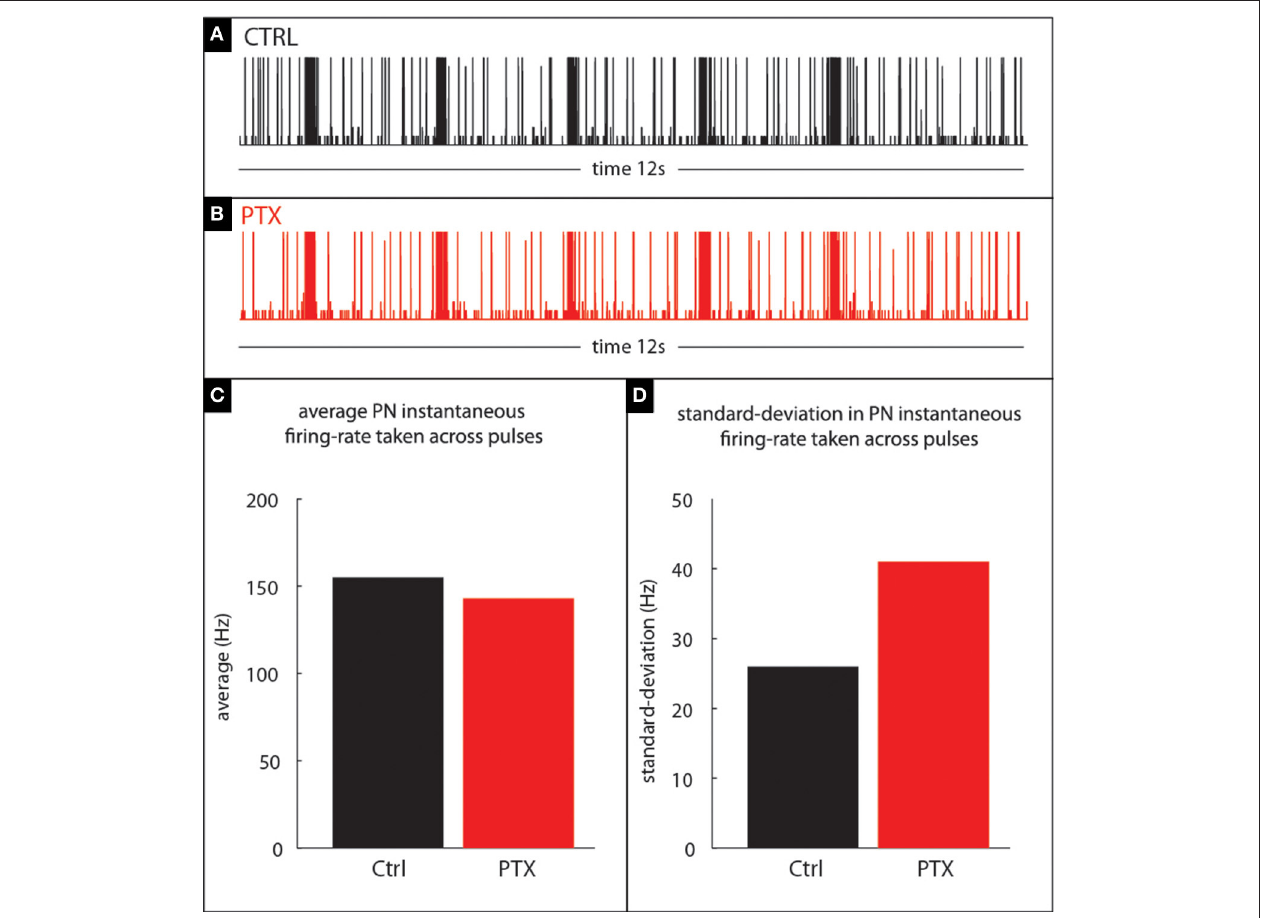
across pulses. (D) The PTX-on state induces larger changes in the standard-deviation (across pulses) of PN-response.